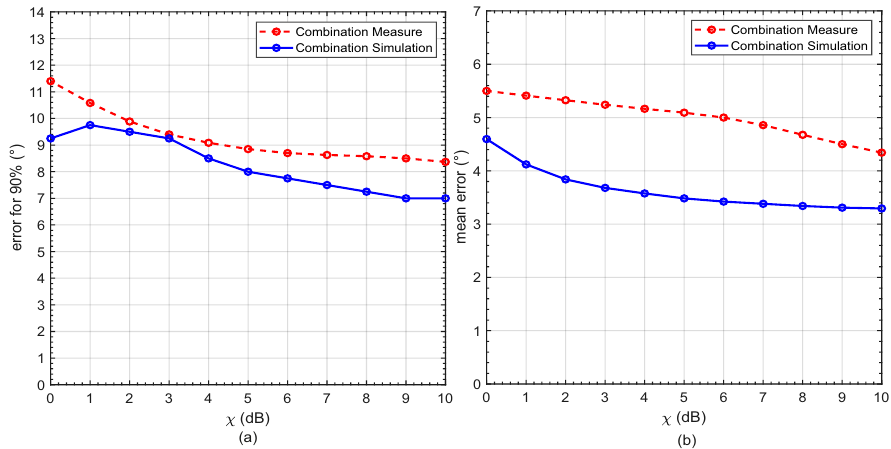
Figure 17. Comparison for D = 2 m between measurement and simulation environment of 90-th percentile combined DoA estimation error ( a ) and Mean combined DoA estimation error ( b ).